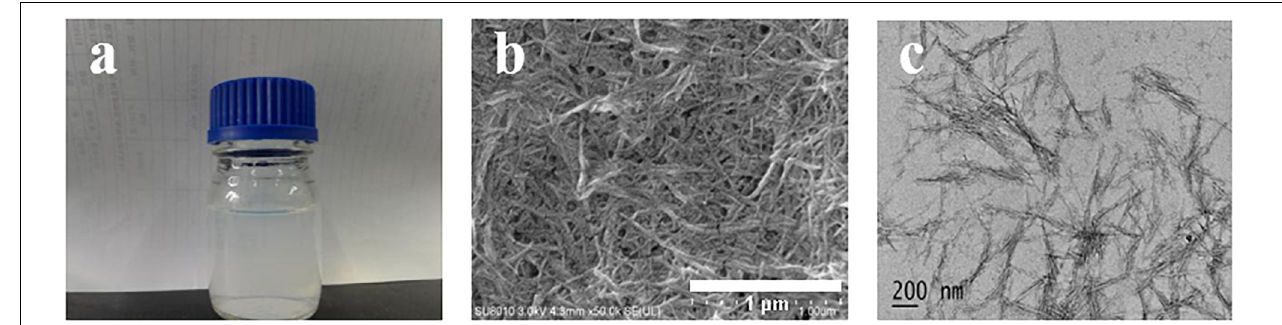
FIGURE 2 | Image of ASCNC. (a) ASCNC suspension; (b) SEM image of ASCNC; (c) TEM image of